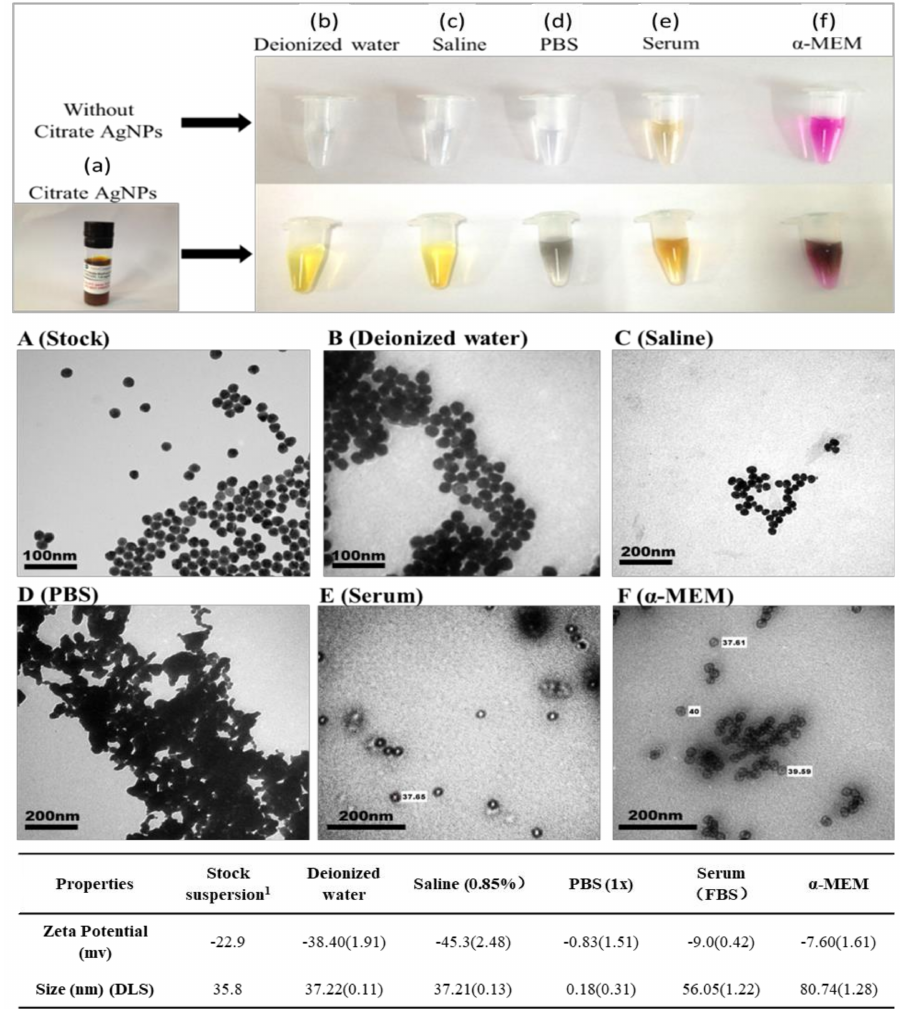
Figure 2. Characterization of Citrate AgNP suspension in di ff erent media. ( a – f ) Photo images of media and Citrate AgNPs in media. ( A – F ) TEM images of Citrate AgNPs in di ff erent media. The table at the bottom shows the zeta potential and size of DLS of Citrate AgNPs in di ff erent media. The PI of DLS in each medium was less than 0.05, except the PI of DLS in PBS medium. (Note 1: the stock suspension of Citrate AgNPs in aqueous 2 nm